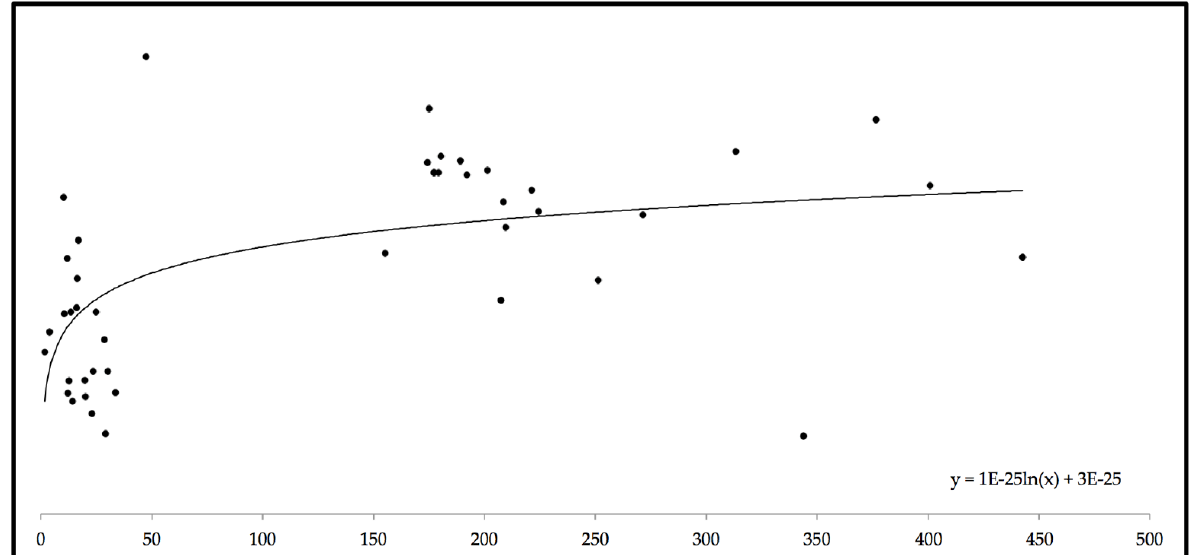
Figure 7. Graphical distribution of the overall entropy and trendline. x axis — b in Ws 1/2 m − 2 K; y ax- is — entropy in J/K.